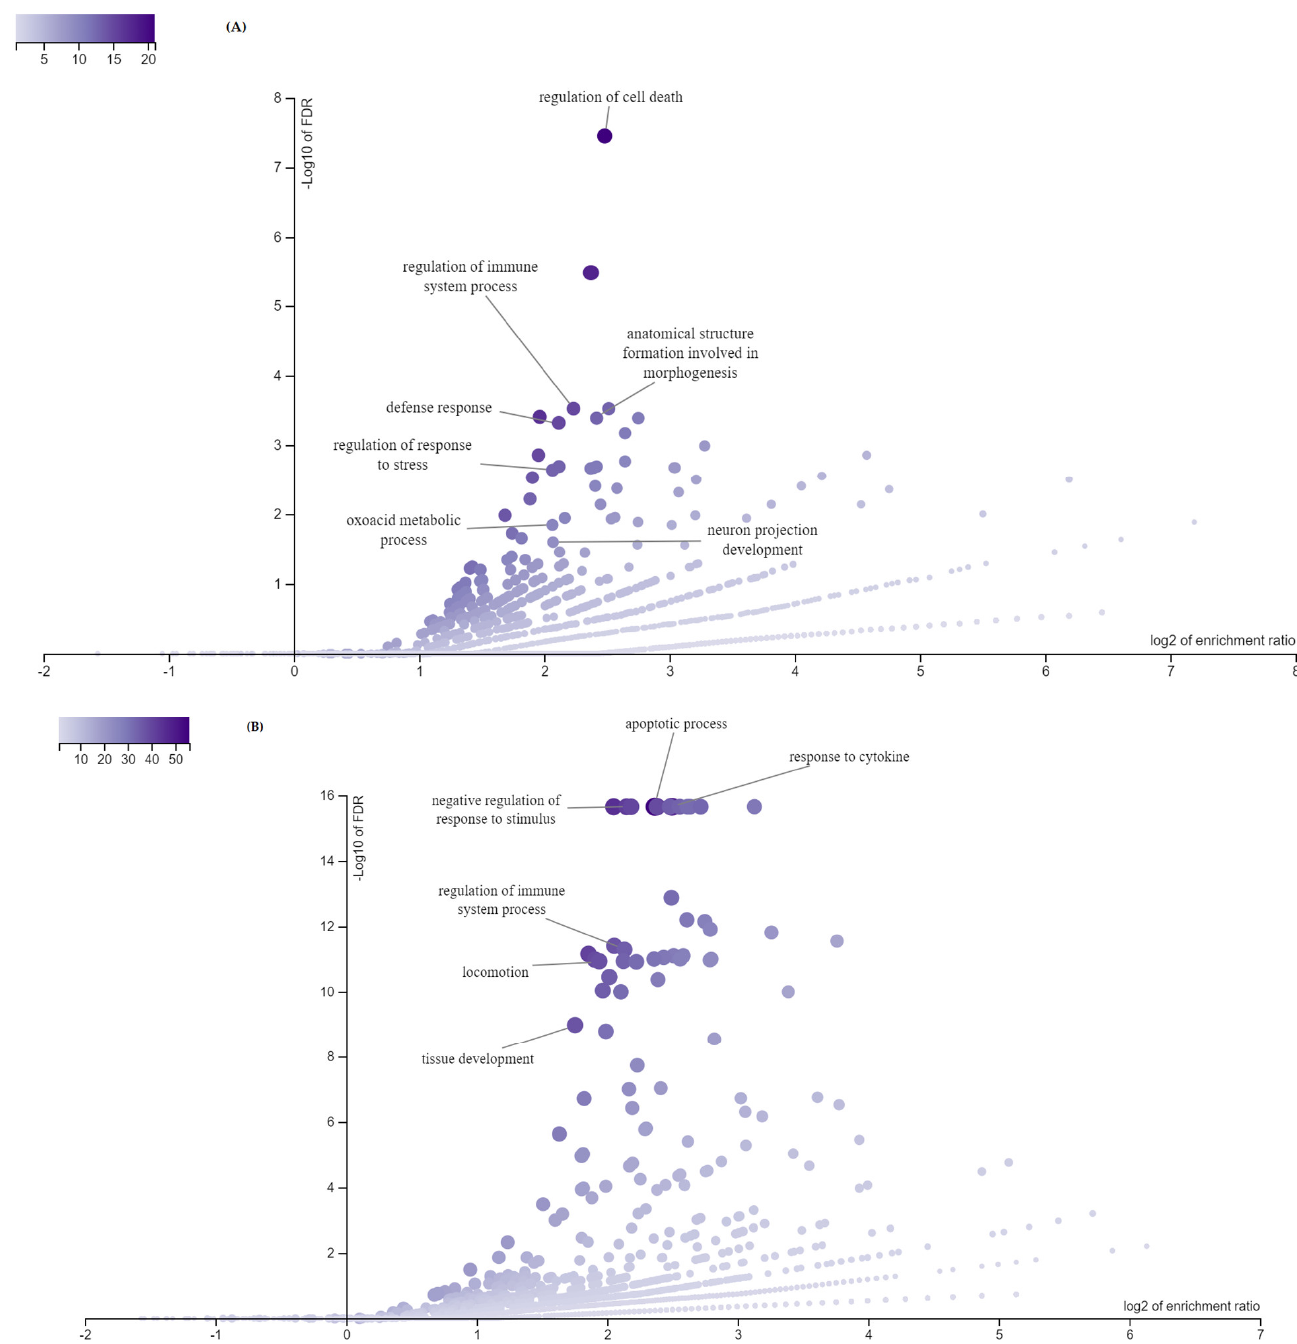
Figure 2. Volcano plot of DEGs expressed in the endometrium ( A ) and the allantochorion ( B ) related to the immune system processes, apoptosis, and extracellular matrix. The size and color of the dots correspond to the size of the gene set. The volcano plot shows − log10 of FDR < 0.05 against log2 enrichment ratio for all the categories. The size and color of the dot are proportional to the size of the category. The position of the dot corresponds to the significance of the category. Analysis was performed in WebGestalt with the use of default settings.